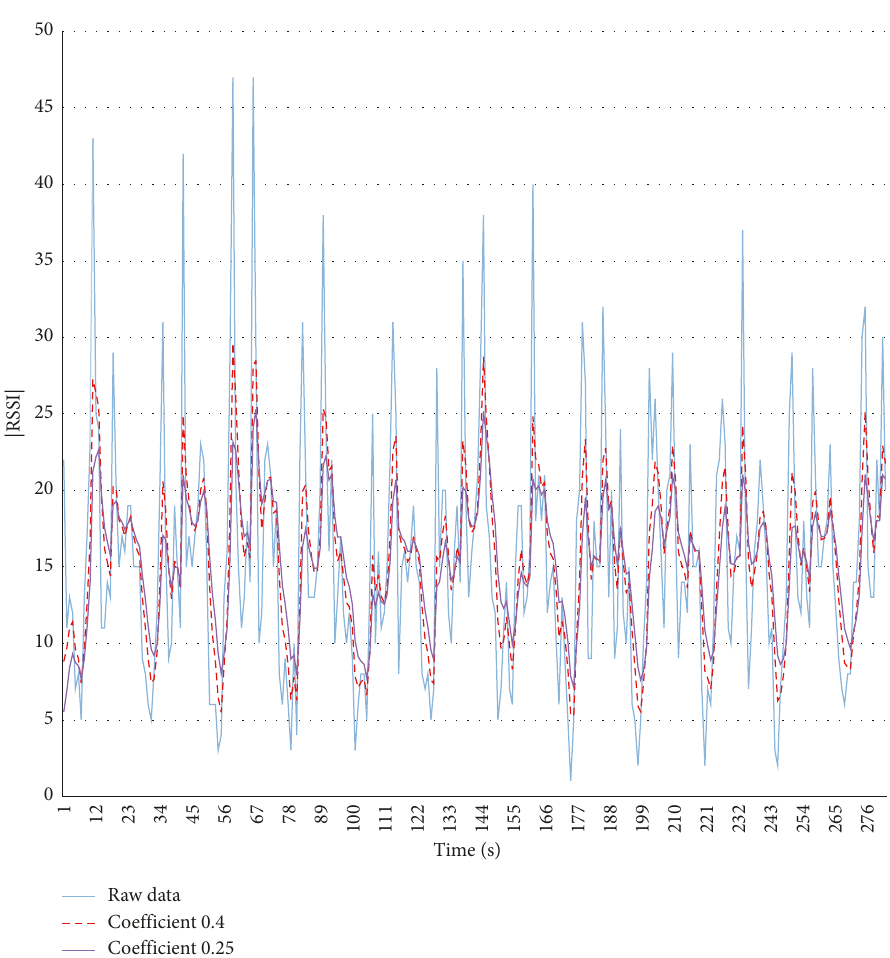
Figure 7: Effect of the single exponential smoothing